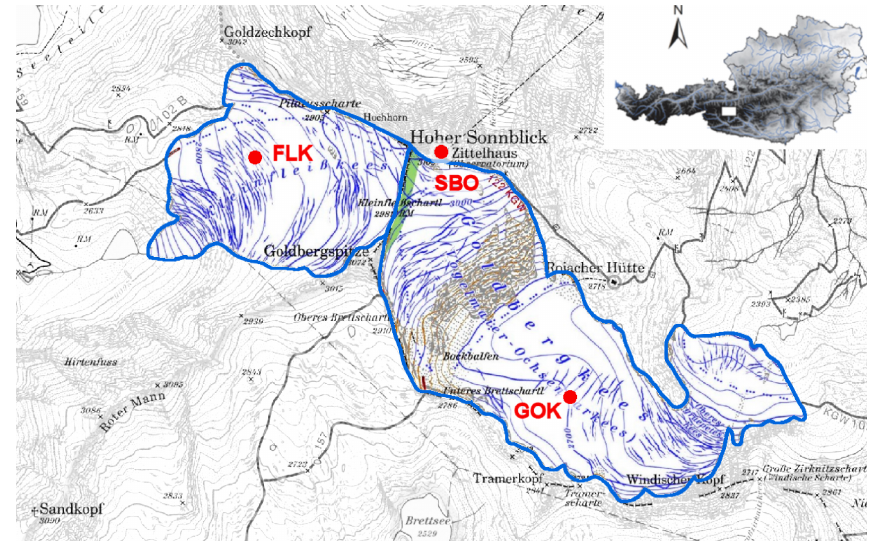
Figure 1. Map of Sonnblick area (taken from Alpenvereinskarten digital 2007, v. 2.0.9.0, DAV, Munich; ÖAV, Innsbruck). The red marks indicate the positions of the AWSs and